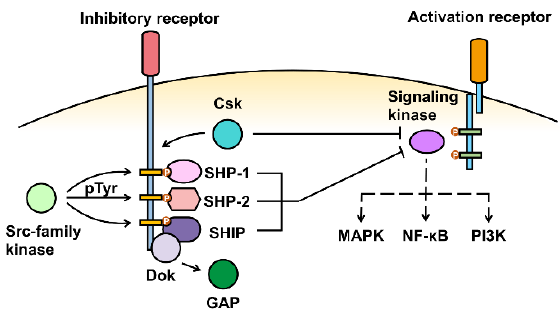
Figure 1. Inhibitory signaling. Inhibitory receptors recruit a Src-family kinase to phosphorylate intracellular immunoreceptor tyrosine-based inhibitory motif (ITIM) which creates docking sites for phosphatases SHPs/SHIP. The recruitment and binding of SHPs/SHIP to inhibitory receptors suppress proximal activation signals mediated by the signaling kinases recruited to the activation receptors. Alternatively, some inhibitory receptors can work through Csk or Dok-mediated inhibition independent of binding to SHPs/SHIP.